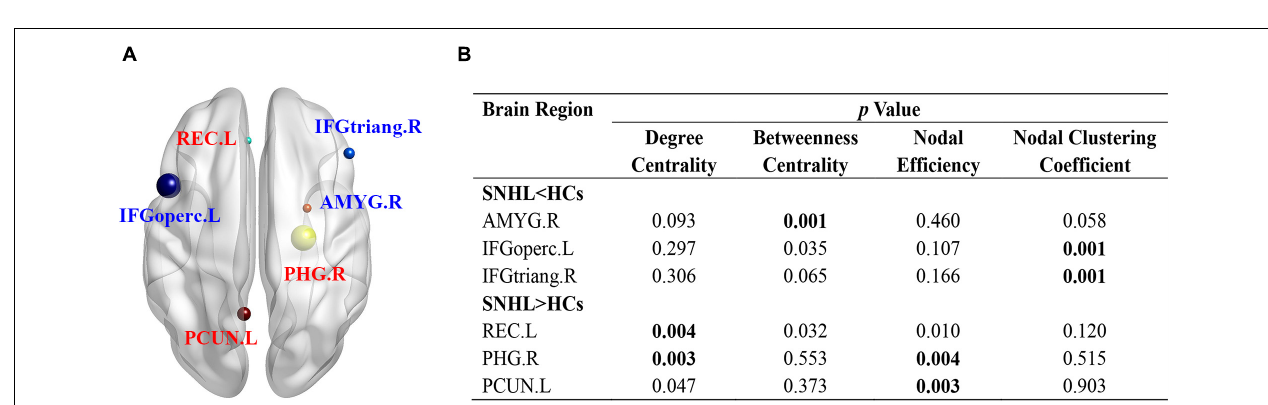
FIGURE 2 | Graph theoretical measurements of whole brain network in SNHL group (blue) and HCs (black). (A) Compared with HCs, the SNHL group had significantly lower AUC of Cp; (B) SNHL group had significantly lower AUC of Lp; (C) there was no significant difference in AUC of local efficiency; (D) the SNHL group had significantly higher AUC of global efficiency than HCs; (E) there was no significant difference in AUC of gamma; (F) the SNHL group had significantly lower AUC of lambda; (G) there was no significant difference in AUC of sigma. SNHL, sudden sensorineural hearing loss; HCs, healthy controls; AUC, area under curve; Cp, cluster coefficient; Lp, characteristic path length. * p <